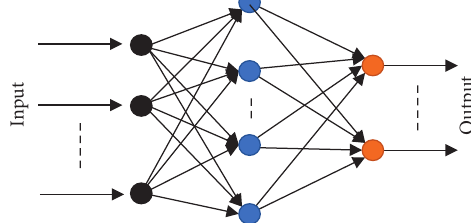
Figure 2: BP neural network